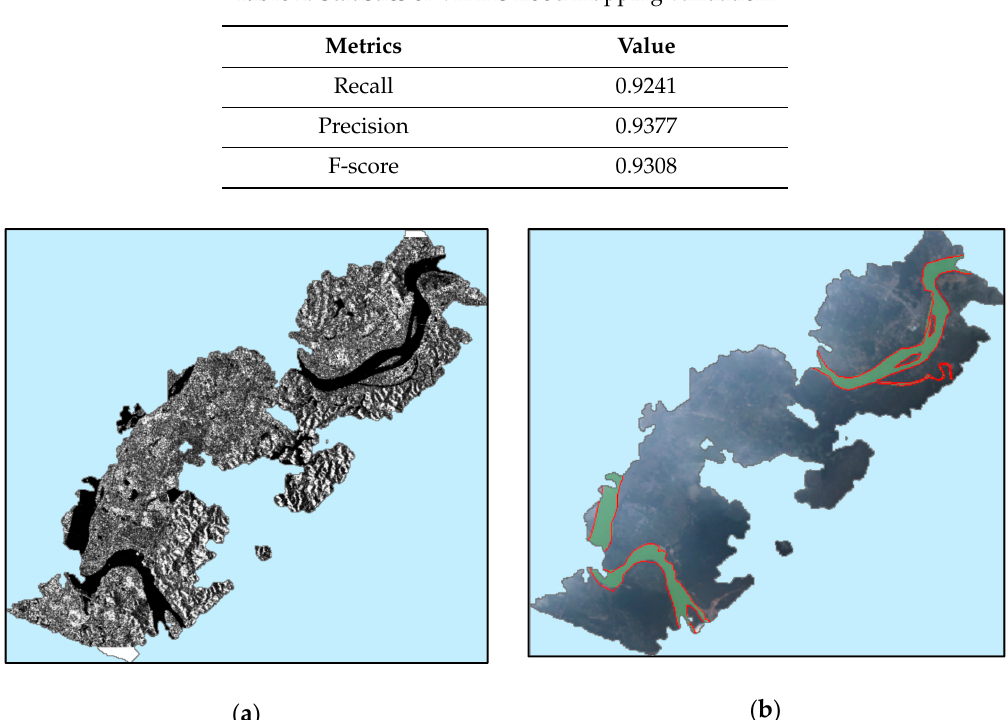
Figure 9. ( a ) Sentinel-1A SAR image. ( b ) Flood map retrieved from SAR (red lines) and volunteered passenger aircraft remote sensing (VPARS) images (green polygons). Table 2. Statistics of VPARS flood mapping validation.